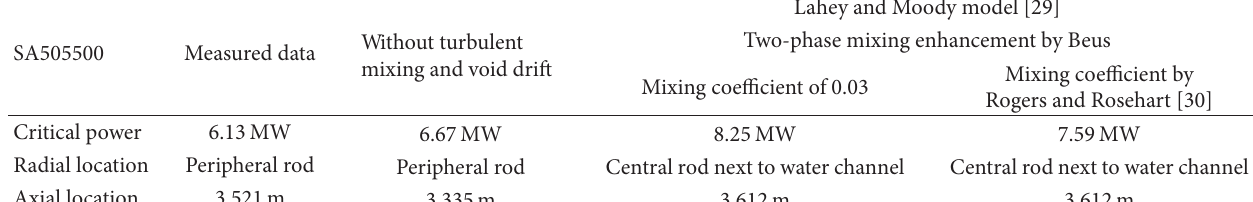
T 2: Results for test case SA505500.